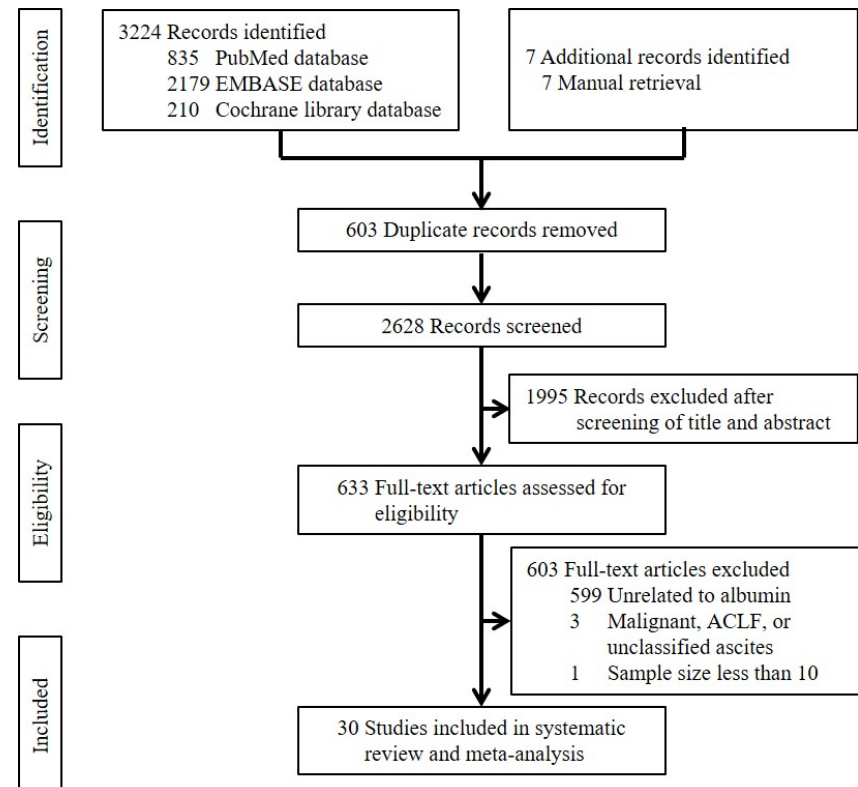
Figure 2. Flow chart of study selection.